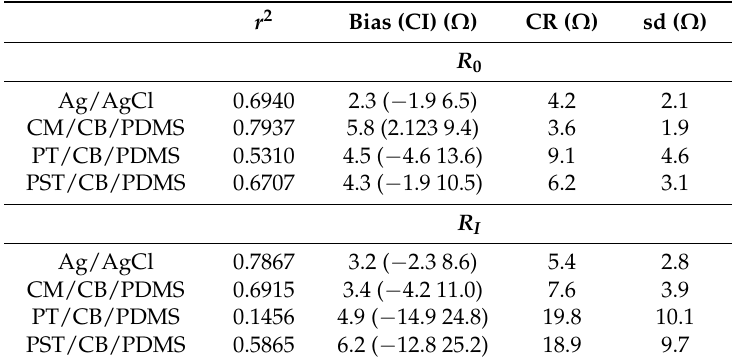
Table 3. Bland–Altman analysis for inter-subject concordance. Textile electrodes were used as